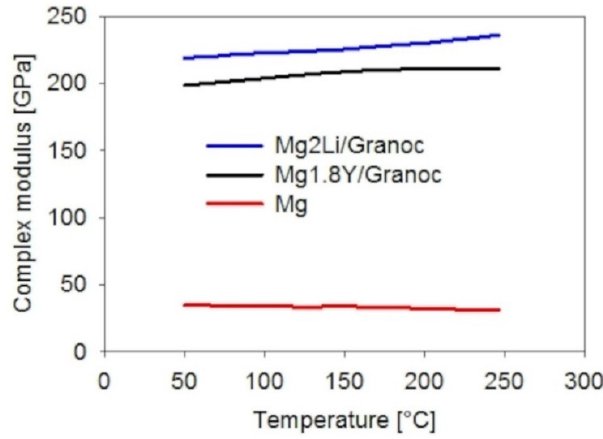
Figure 15. Complex modulus values of the composites with Granoc fibers.